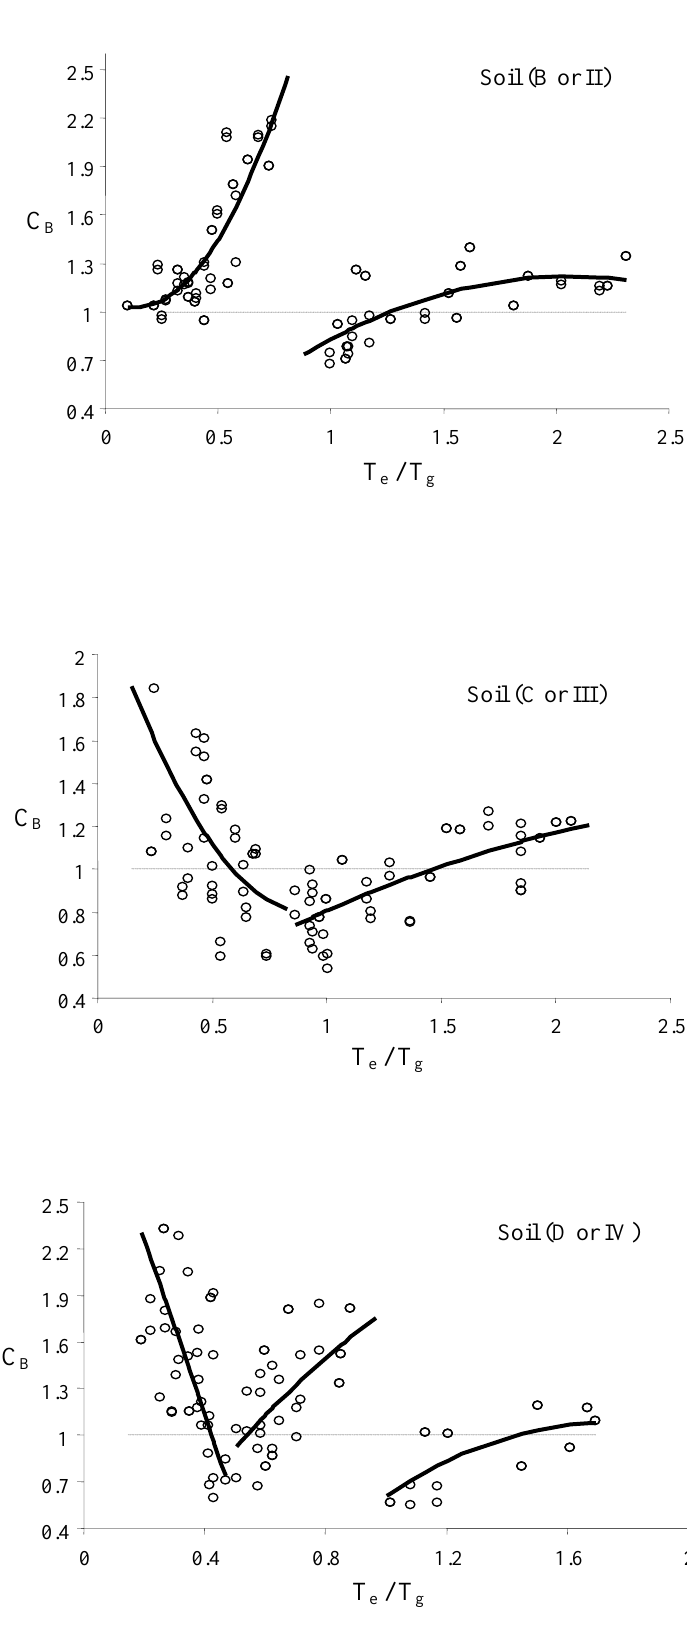
) curve for soils B